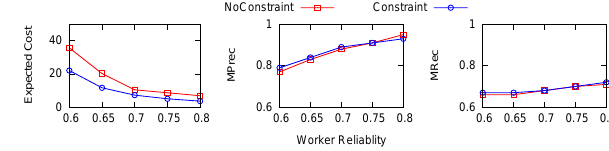
Figure 11. Effects of worker reliability on answer aggregation